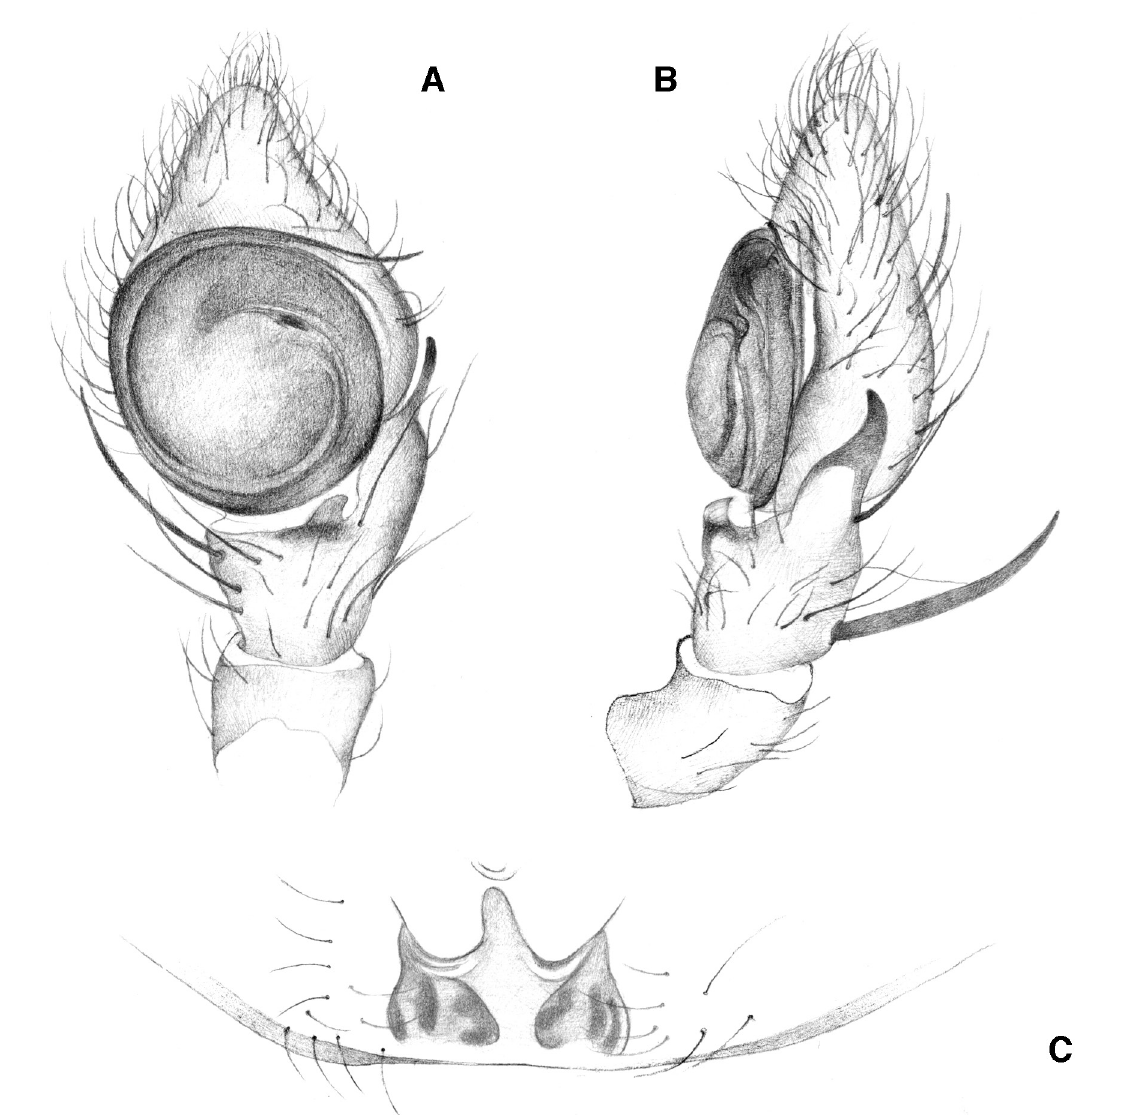
Fig. 2. Mecaphesa reddelli sp. nov. A . ♂ palp, ventral view. B . ♂ palp, retrolateral view. C . ♀,